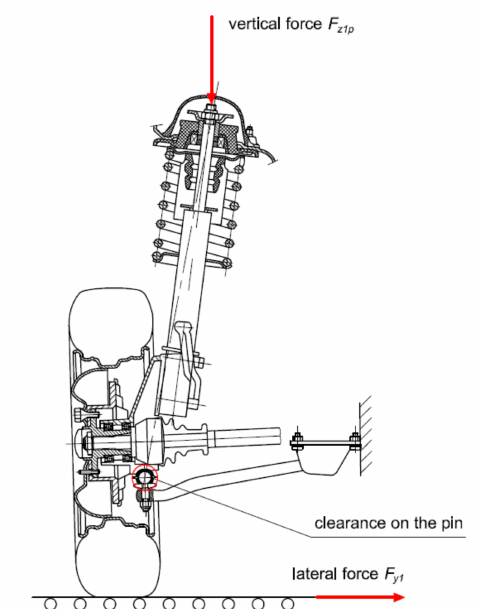
Figure 7. Measurement of the required lateral force to eliminate the rocker arm